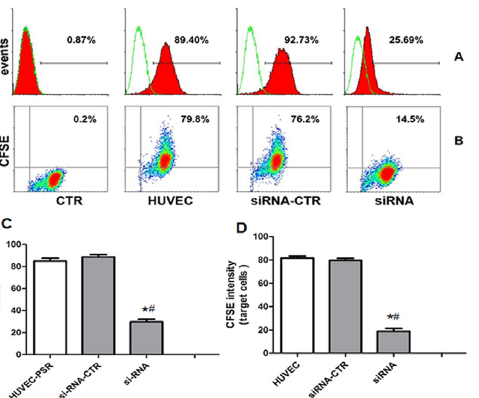
Fig 9. Down-regulation of PSR in HUVECs inhibits their up-taking of MSC-MVs. (A) PSR expression on HUVECs, PSR siRNA-transfected HUVECs (siRNA) and control RNA-treated HUVECs (siRNA-CTR) was evaluated by flow cytometry. The hollow diagrams represent the fluorescence intensity of cells reacted with the FITC-conjugated antibody. (B) The uptake of CFSE-labeled MSC-MVs was observed with flow cytometry. X-axis: the forward scatter corner signals. Y-axis: CFSE intensity. (C)The t-test showed that the PSR expression was significantly decreased by si-RNA (vs.CTR * P < 0.05; vs.siRNA-CTR # P < 0.05). (D) PSR siRNA significantly inhibited the internalization of MVs (vs.CTR * P < 0.05; vs.siRNA-CTR # P < 0.05). These results are representative of the data from three separate